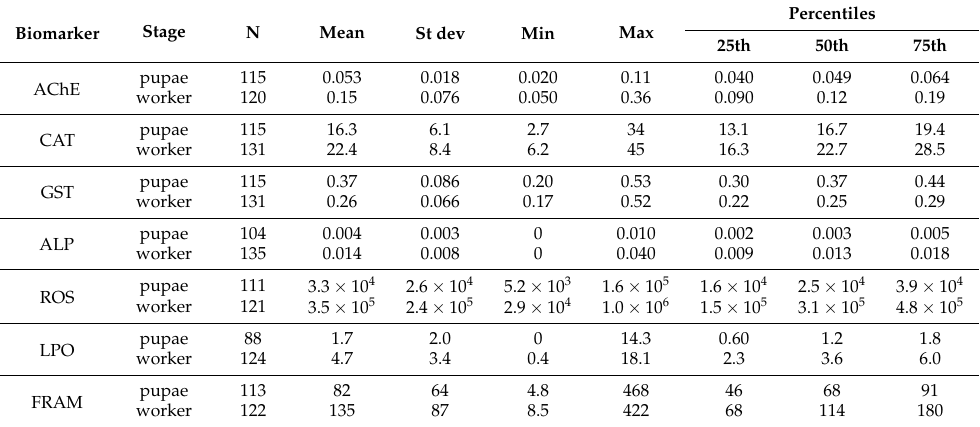
Table 5. Number of data (N), mean value, standard deviation (St dev), minimum, maximum and percentiles of AChE activity (U/mg protein), CAT activity (U/mg protein), GST activity (U/mg protein), ALP activity (U/mg protein), ROS level (AU/g f.w.), lipid peroxidation (nmol TBARS/g